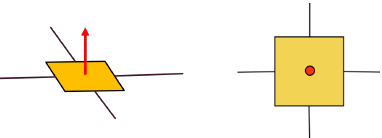
Figure 3. Tensor network representations of the 4-qubit code. The red dangling leg represents the single qubit input degree of freedom, while the 4 in-plane legs represent the 4 physical qubits in the output Hilbert space. An equivalent figure on the right uses a red dot to denote the logical qubit when the tensor is viewed from top